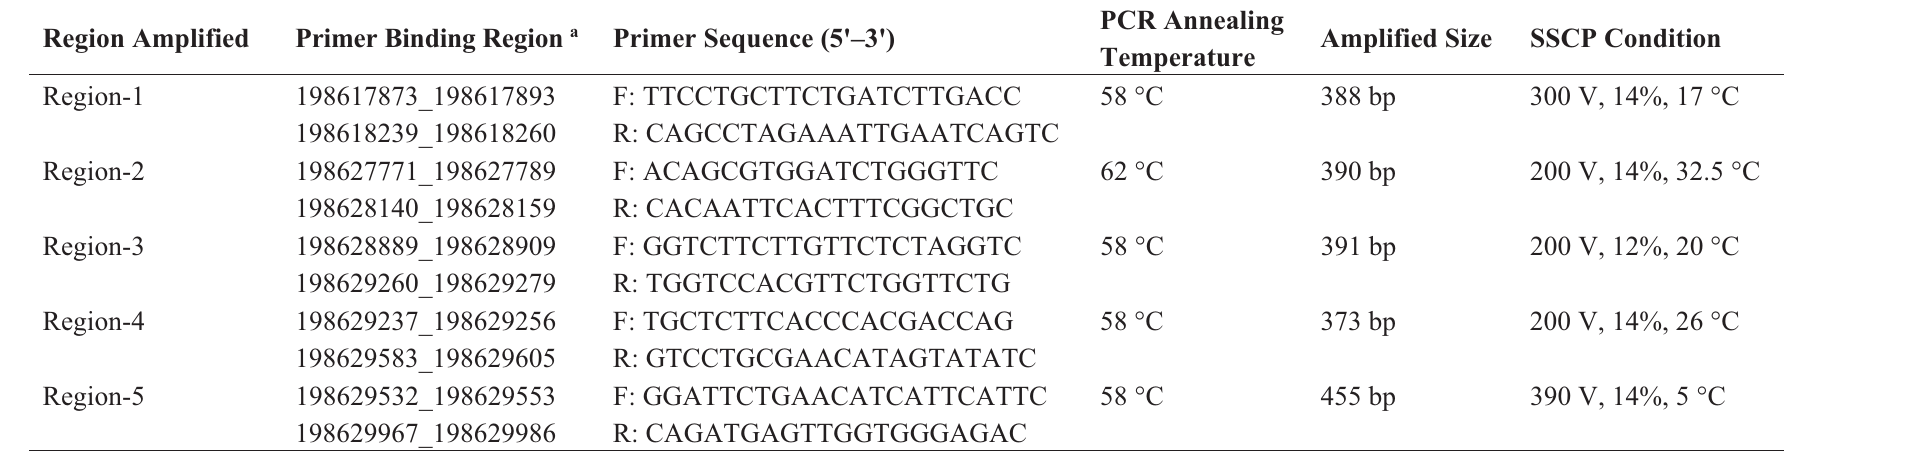
Table 1. The primer sequences and PCR-SSCP conditions used for analysis of ovine ADIPOQ